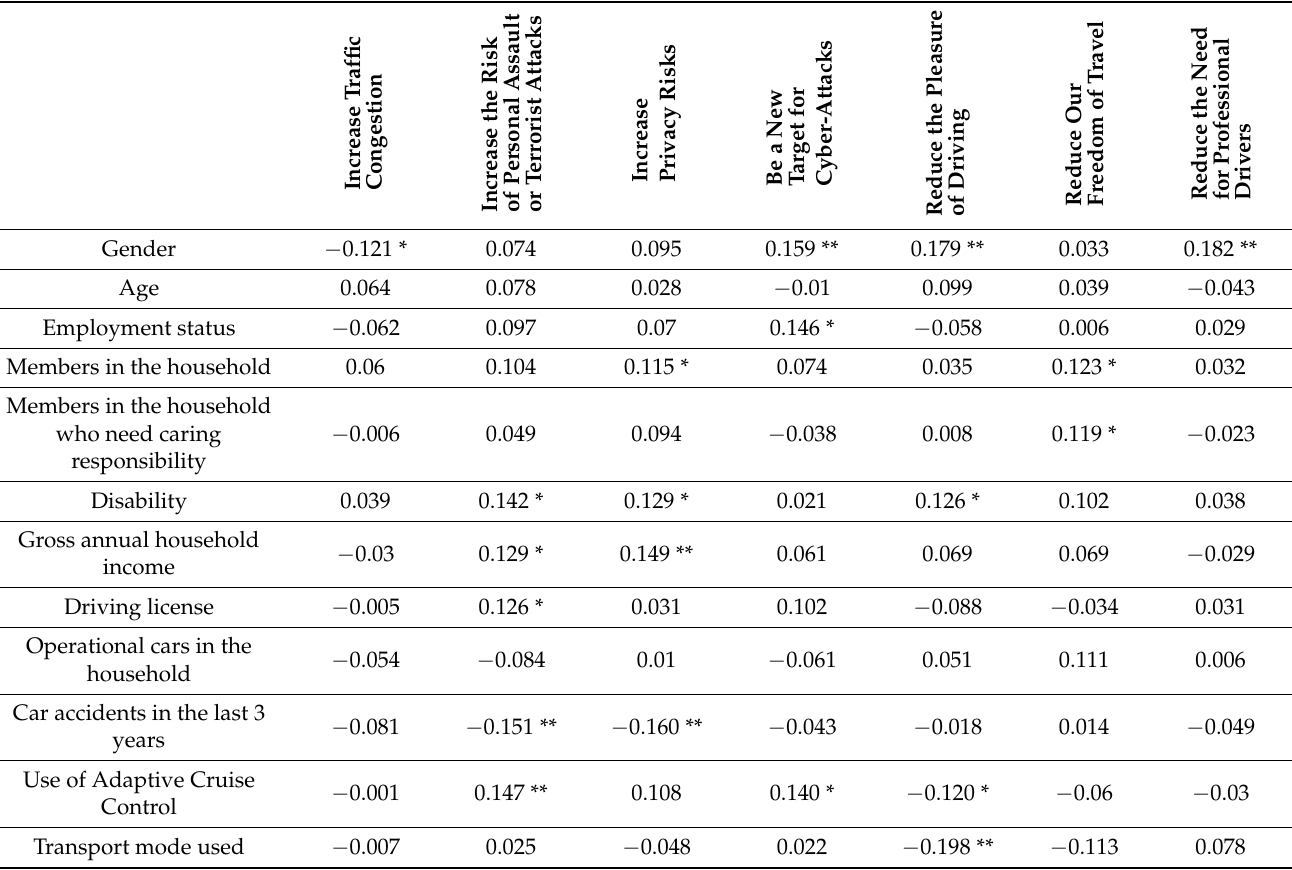
Table 11. Spearman correlation between socio-economic characteristics of the sample and potential concerns about AVs (Source: Authors’ survey